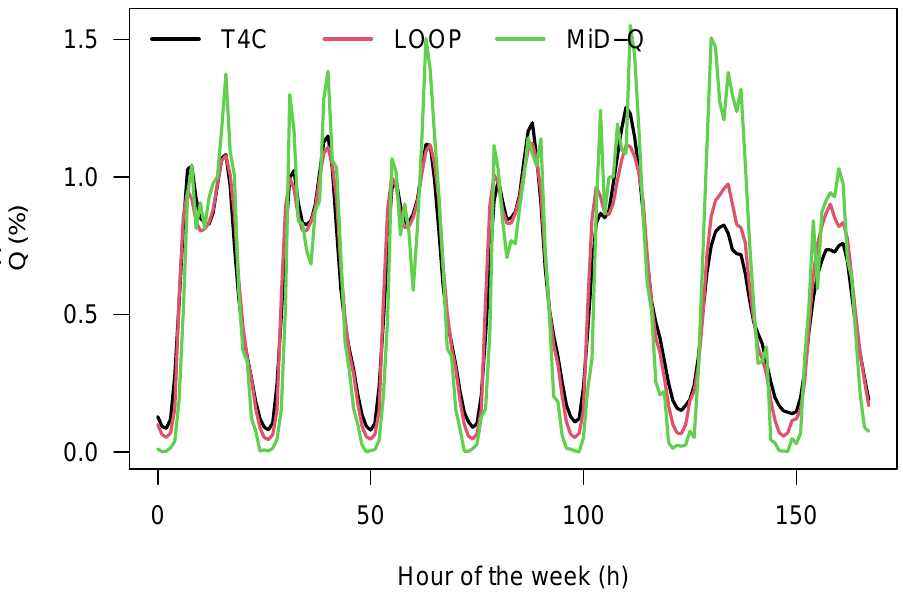
Figure 8. Comparison of the weekly flow pattern ˆ Q ( h ) obtained from the T4C, the LOOP, and the MiD-Q